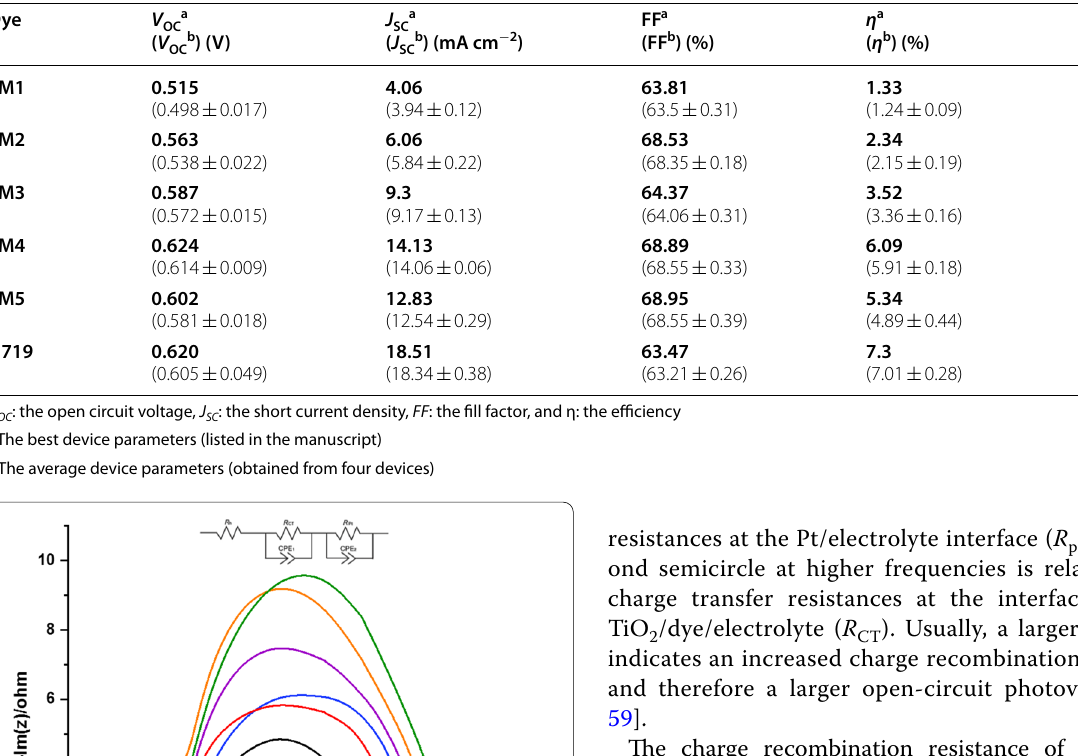
Table 3 J–V parameters of SM1-5 and N-719